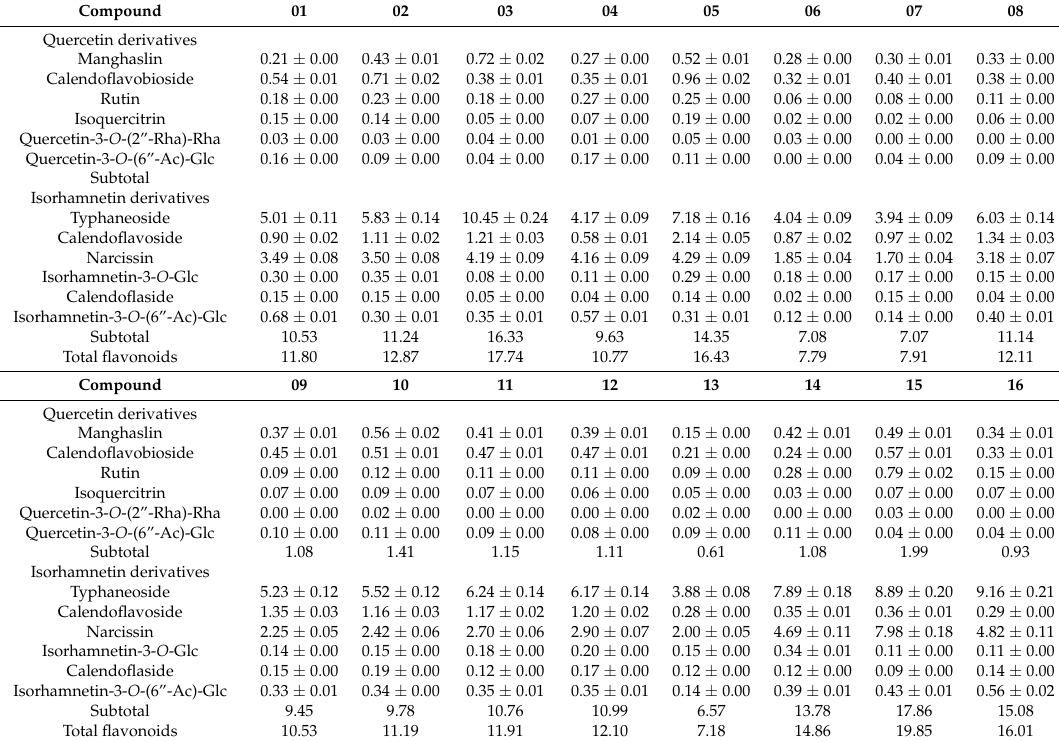
1 Averages ± standard deviation were obtained from three different experiments. Abbreviations used: Glc p , glucopyranose; Ac, acetyl; Rha p ,